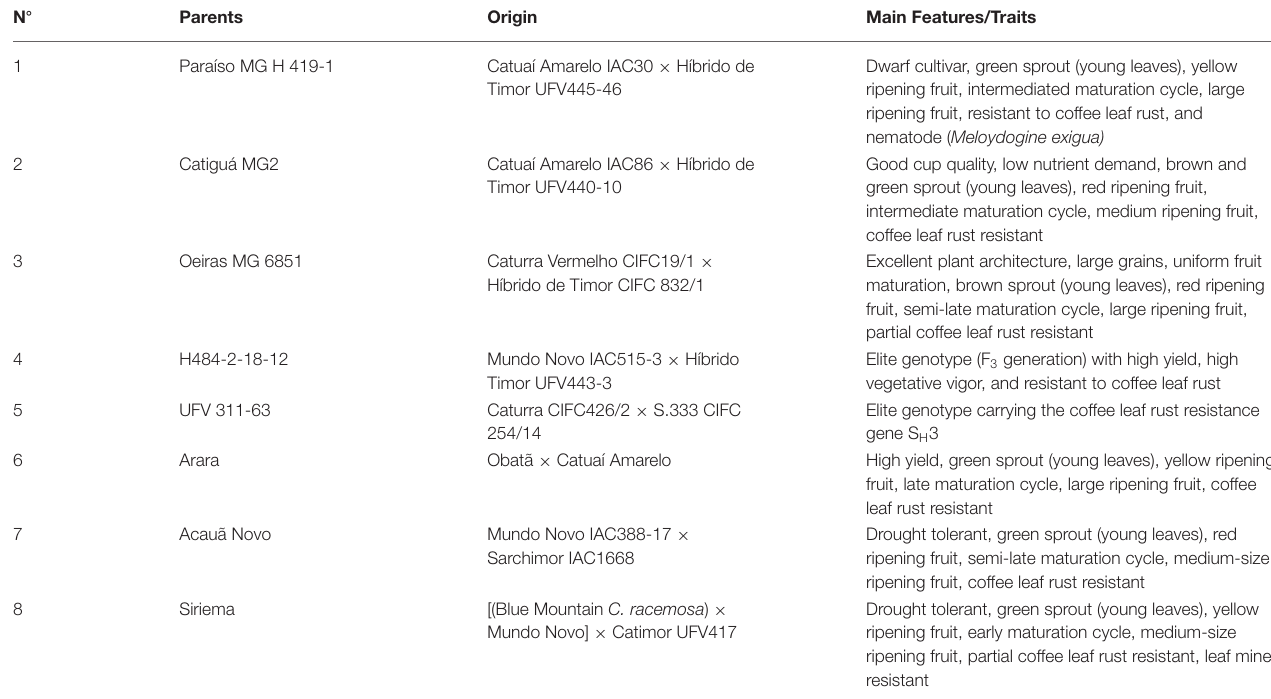
TABLE 2 | Parents used in the diallel crossing.